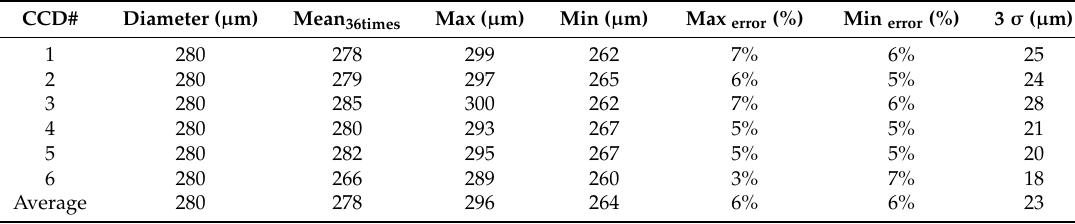
Table 2. Results for Detected Protrusion on BM